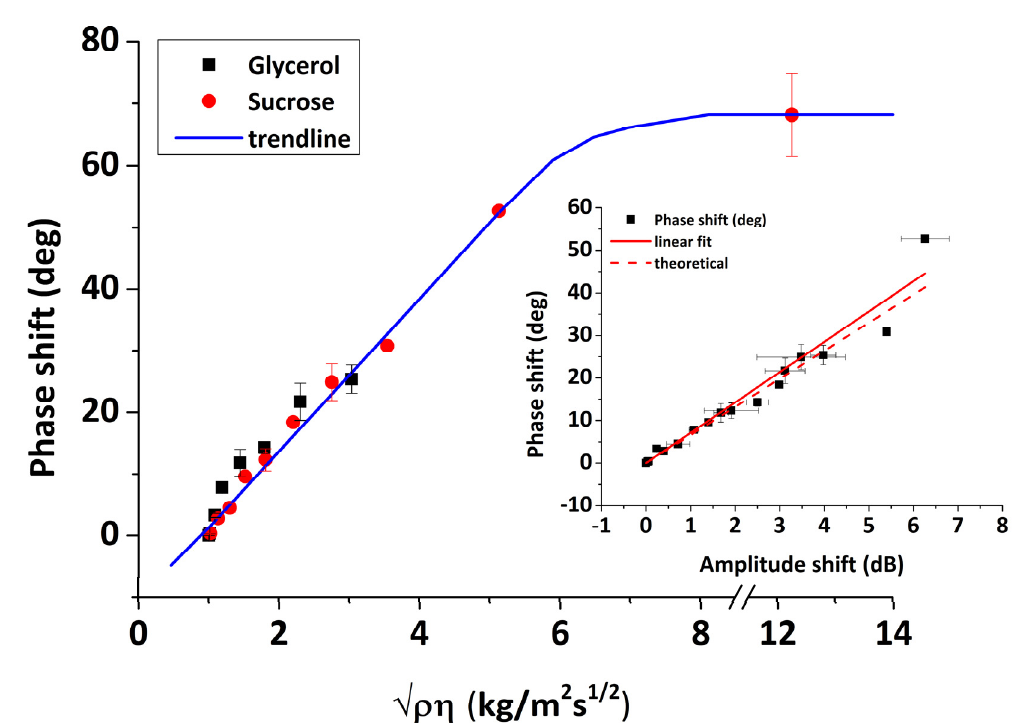
Figure 14. Phase response versus the square root of the density–viscosity product for glycerol/water and sucrose/water solutions. ( inset ) Phase versus amplitude response (solid line, linear fit for the experimental data 7.12 deg/dB; dashed line, theoretical slope 6.6 deg/dB).